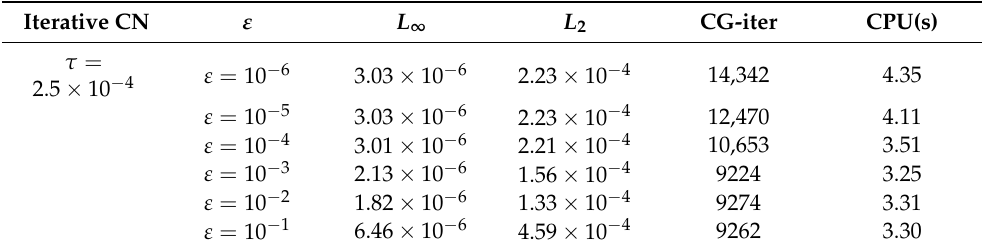
Table A2. Comparison of the iterative CN scheme linked to the CG method in terms of the termination of the algorithm using the relative residual for different values of ε . We evaluate the accuracy of the artificial setup (A26) at t F = 1 for the grid size h = 0.01. The analytical solution (A27) is evaluated for k = 1 and truncated at n = m =